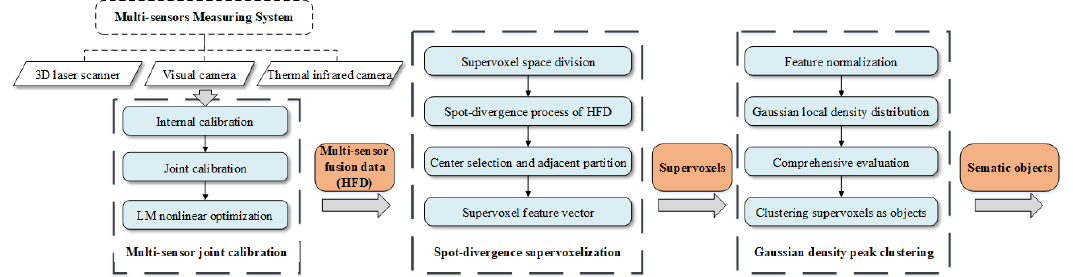
Figure 8. The analysis flow of semi-supervised segmentation framework for AFMs.